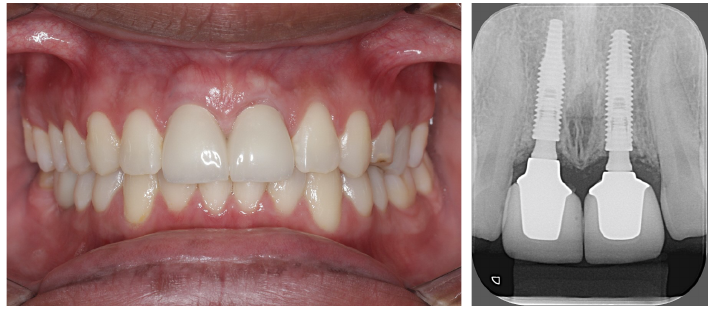
Figure 15. Front view and periapical X-ray showing the stability of the bone tissue.